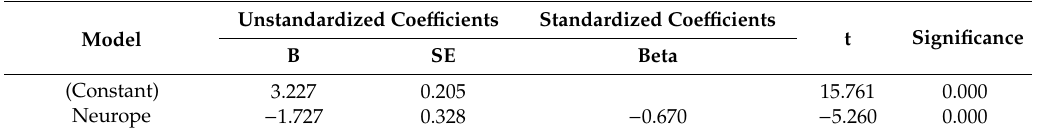
Table 8. Alternative linear regression model for